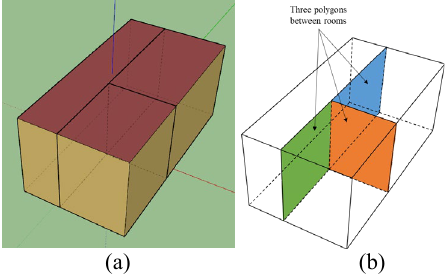
Figure 15. Scenario 6 result. (a) SketchUp visualization; (b)